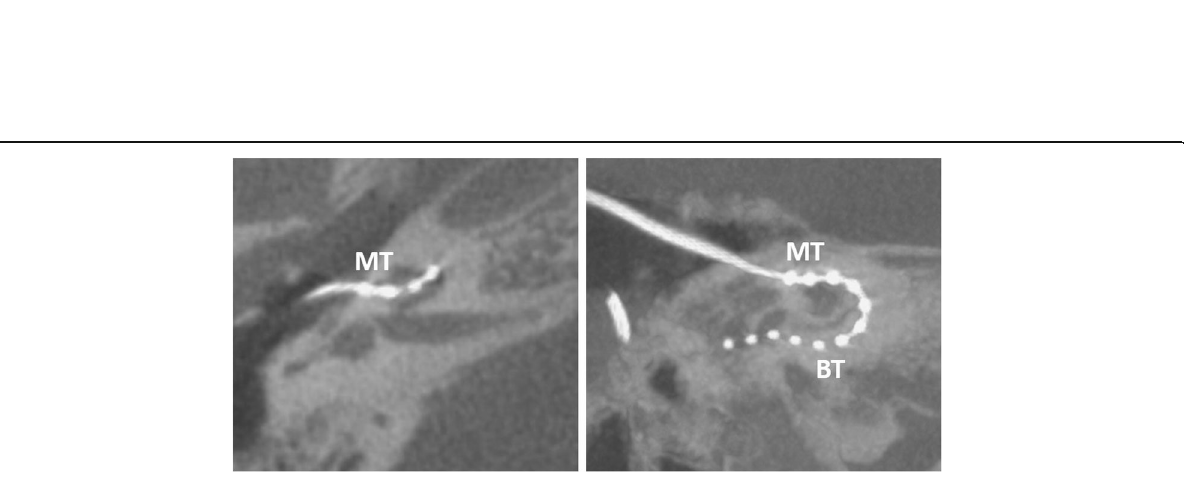
Fig. 22 A 51-year-old male patient, with normal postoperative finding after retrograde electrode surgery due to cochlear fibrosis. CBCT axial image (left image) shows electrode entering at the middle turn (MT). CBCT paraaxial maximum intensity projection image (right image) shows the electrode running down the basal turn (BT). The two most distal electrode contacts are in the tympanic space and need to be